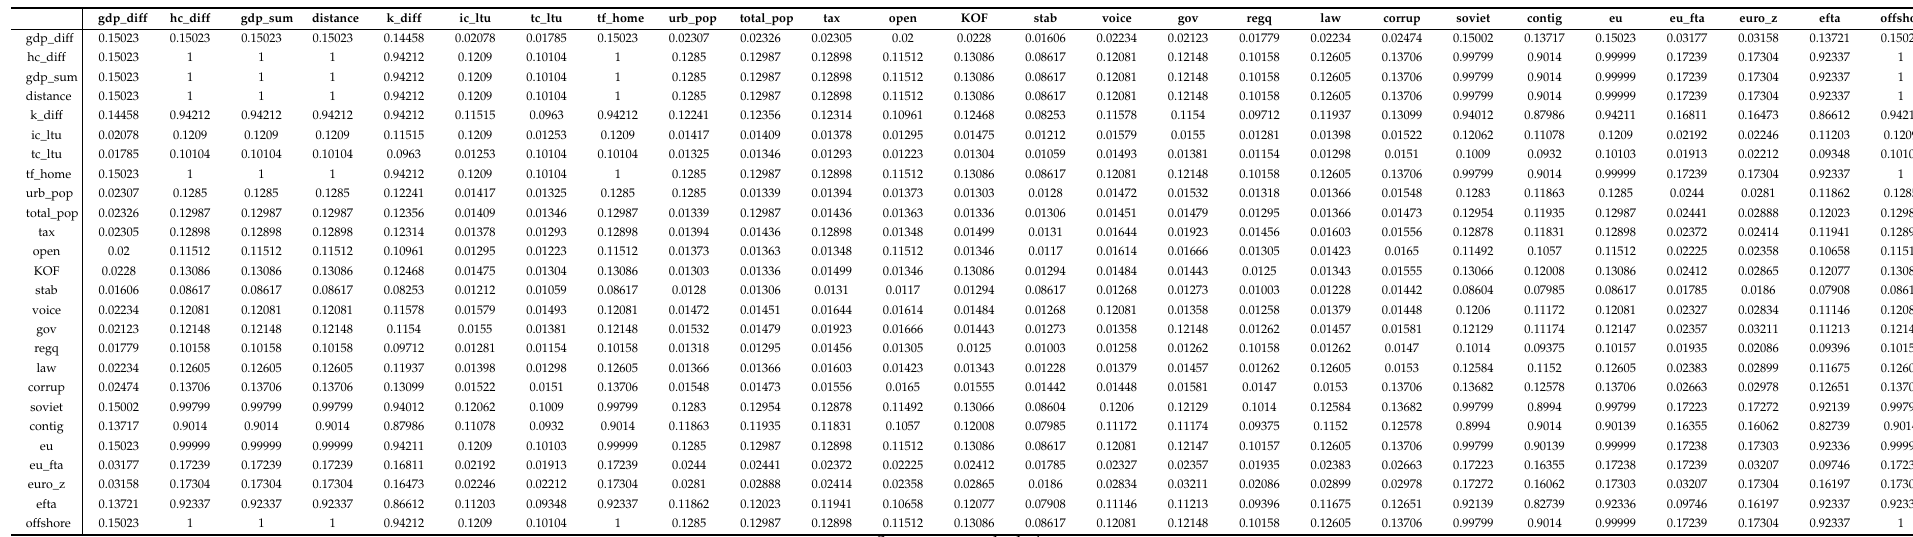
Table A10. Lithuania, general case: the joint inclusion probability for all